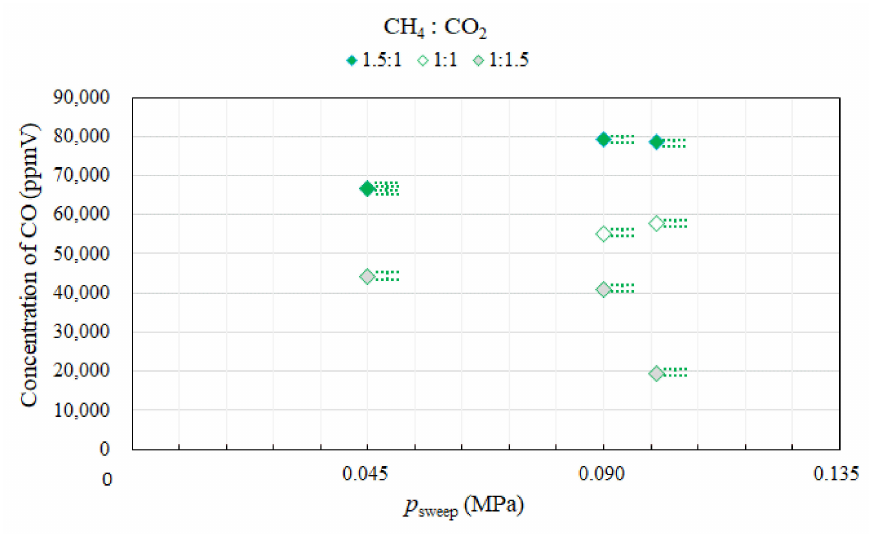
Figure 8. Relationship between concentration of CO at the outlet of reaction chamber and p sweep of with changing molar ratios of CH 4 :CO 2